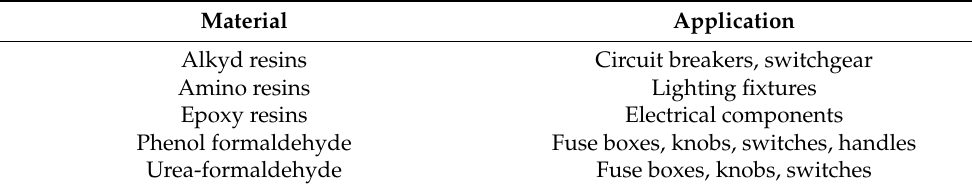
Table 3. Common thermoset polymer for electrical